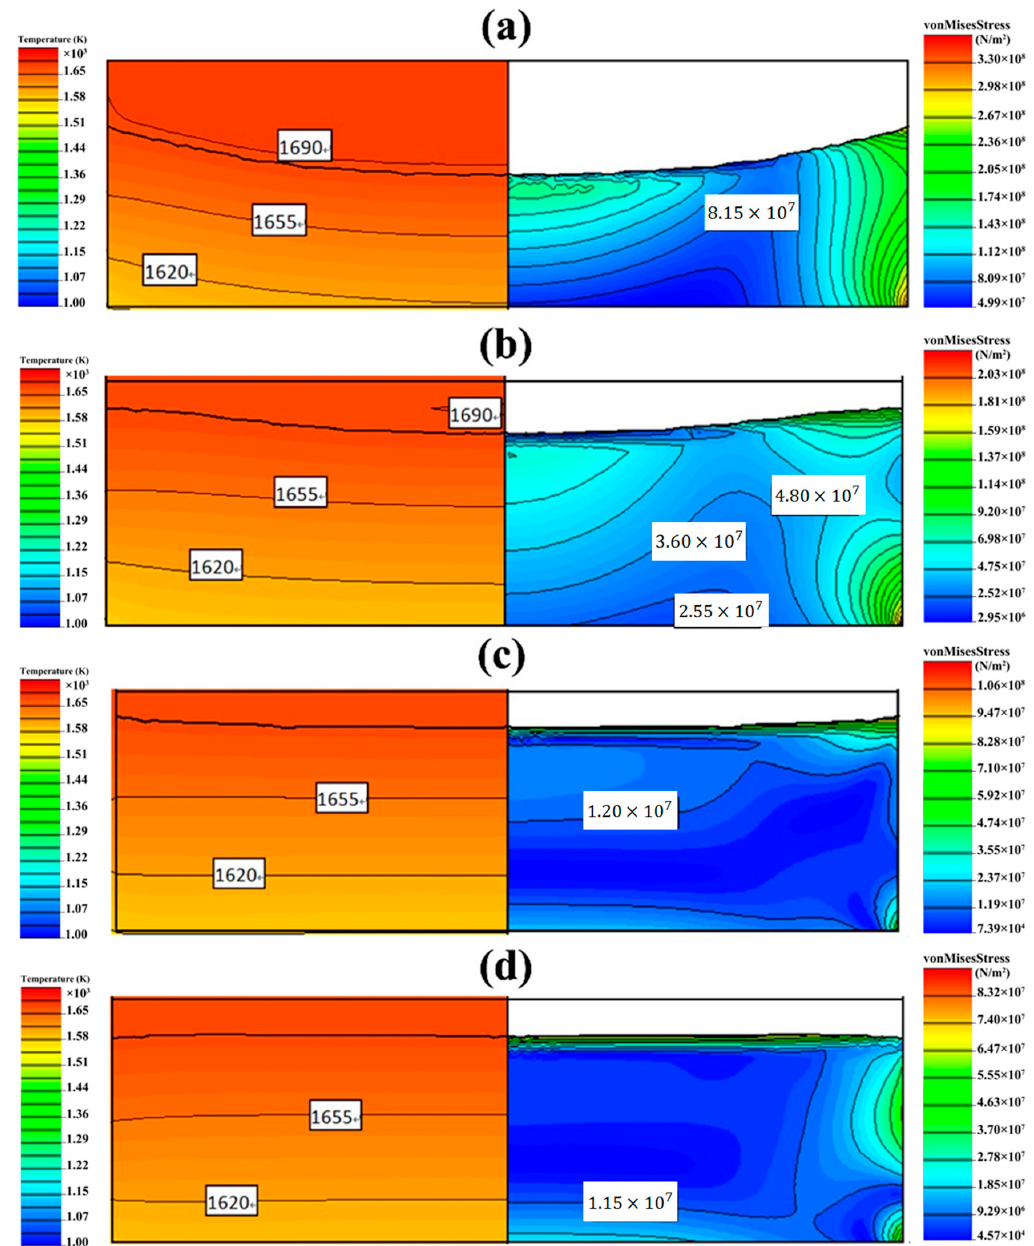
Figure 6. ( a – d ) Temperature distribution and thermal stress of different cases at the end state.